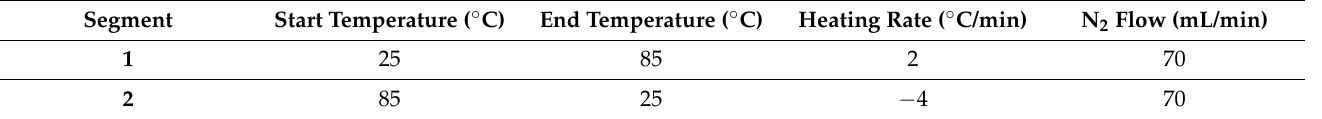
Table 9. DSC scanning